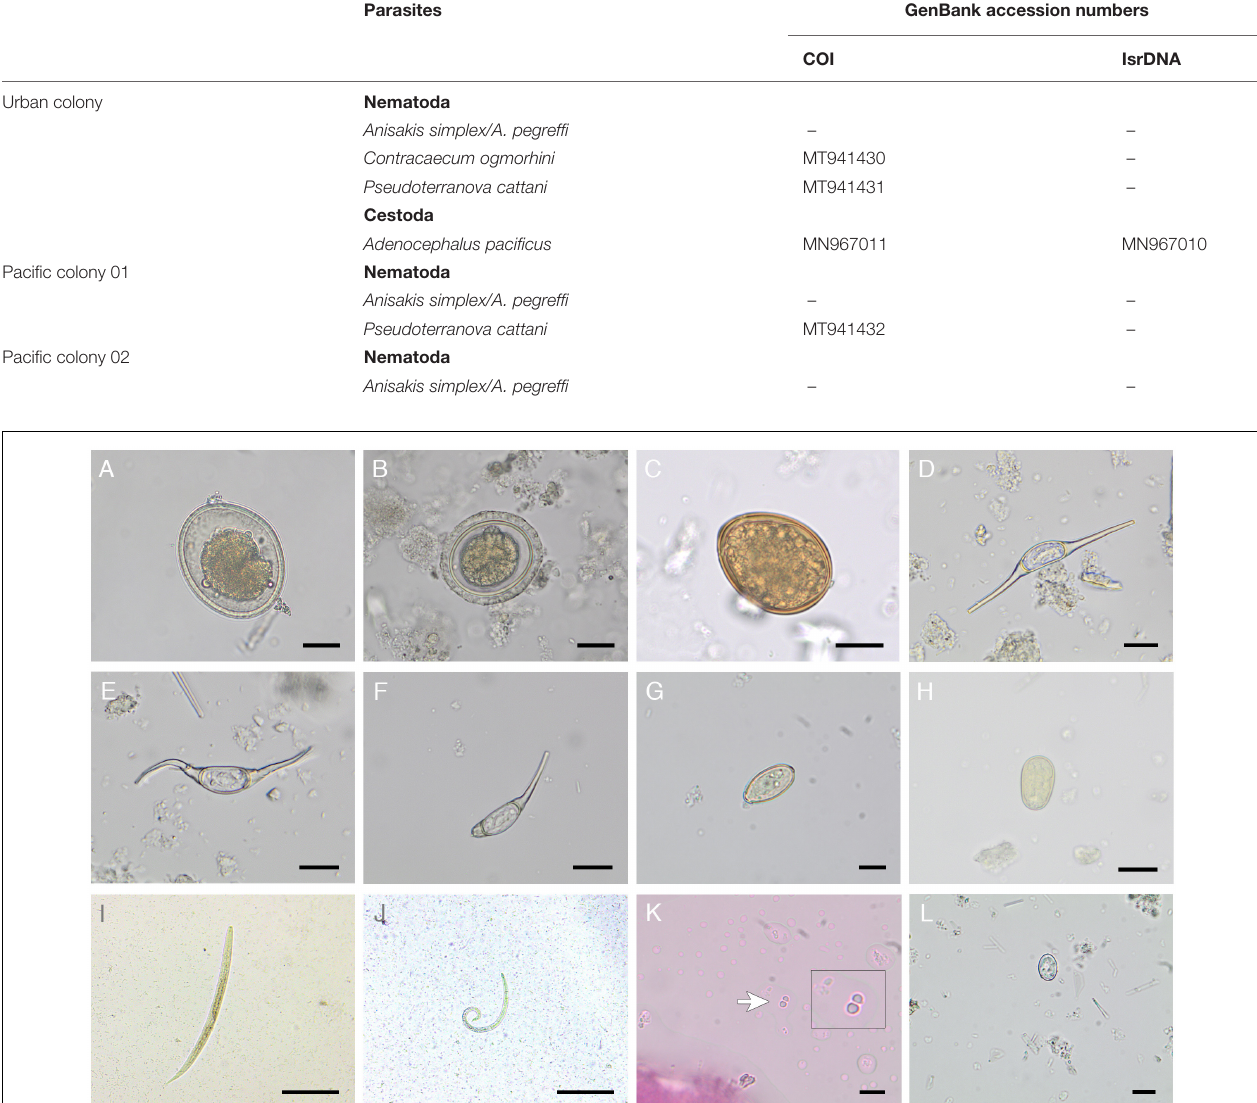
TABLE 3 | Molecular identification of nematodes and cestodes isolated from Otaria flavescens fecal samples within this study.